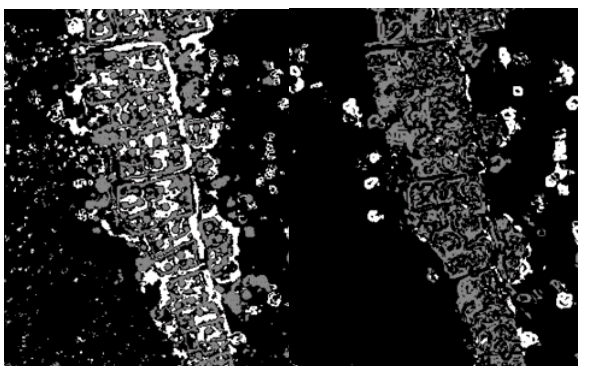
Fig. 7 Change detection by post classification (left) and CEST (right)